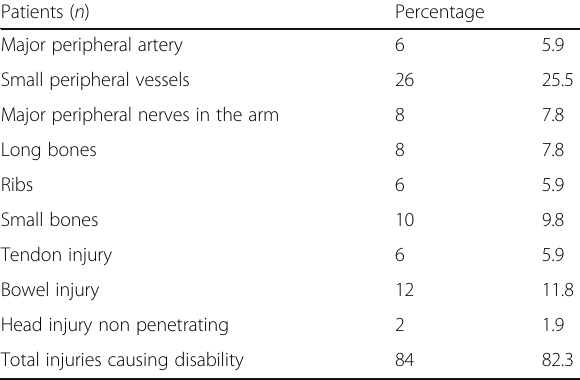
Table 3 Affected anatomical structures by firearm injuries ( n